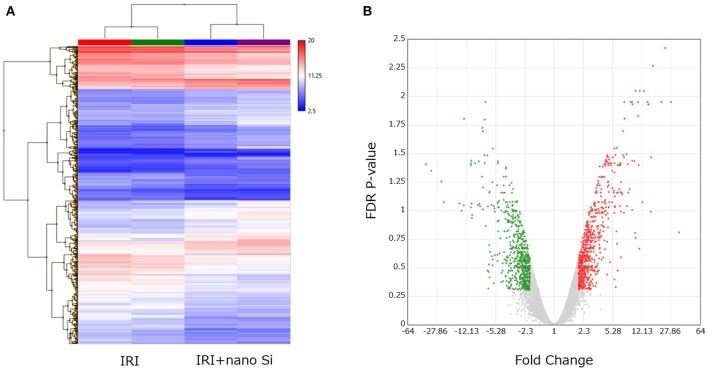
Changes in the renal transcriptome at 72 h after IRI. (A) Hierarchical clustering of each sample dataset by renal tissue microarray. (B) Volcano plot showing the upregulated and downregulated genes in the kidneys of rats with IRI treated with nano-Si compared to those maintained with a normal diet (fold change, >2.0 or <2.0; p < 0.05). n = 2.